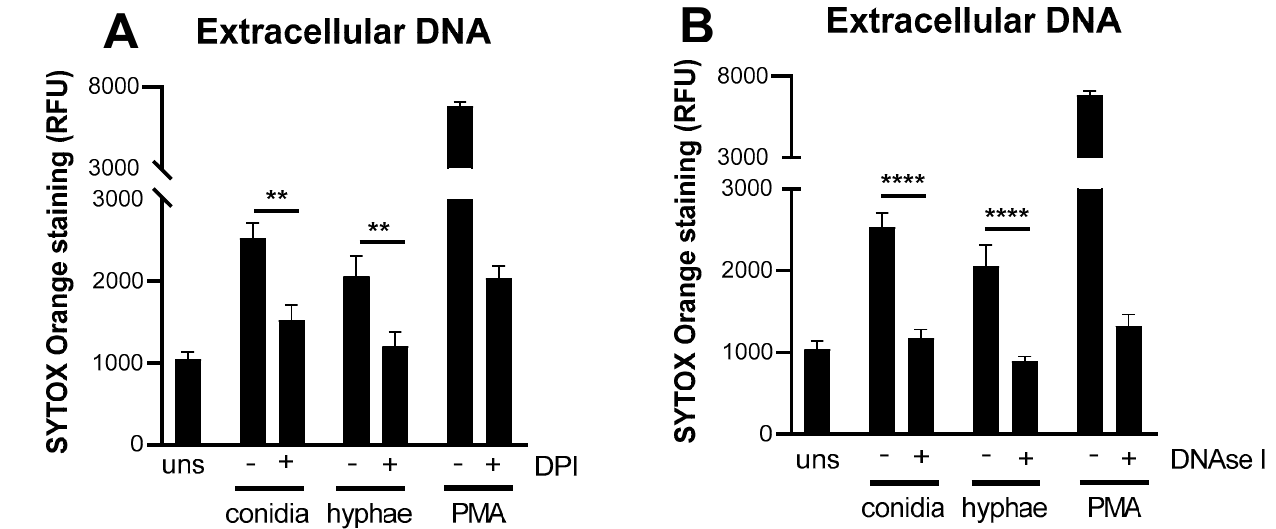
Figure 3. NET formation by human neutrophils against T. rubrum is dependent on ROS production. Neutrophils were pre-treated with DPI or DNase I before stimulation with T. rubrum morphotypes and incubated for 3 h. Extracellular DNA was quantified using SYTOX Orange by measuring its fluorescence intensity (expressed as relative fluorescence units, RFU). ( A ) Effect of DPI treatment on NET induction. ( B ) Effect of DNase I. Data shown as the mean ± SEM of three independent experiments. One-way ANOVA and Bonferroni’s post-test: ** p < 0.01; **** p < 0.0001.